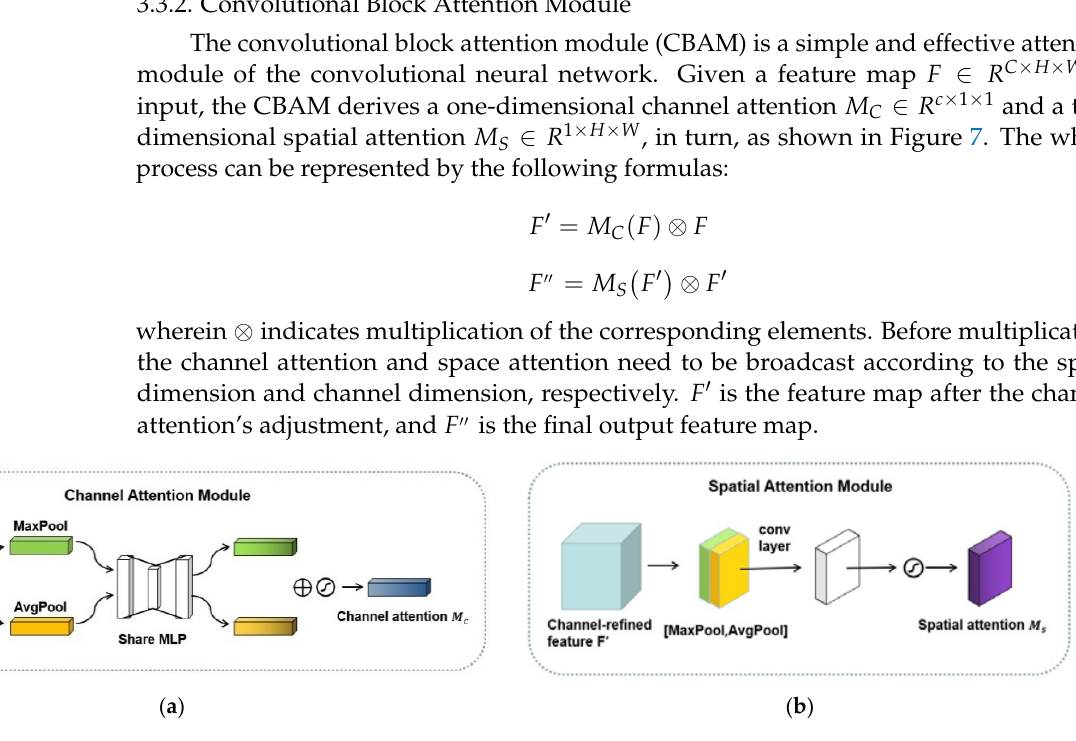
Figure 7. ( a ) Channel attention module in CBAM; ( b ) spatial attention module in CBAM.